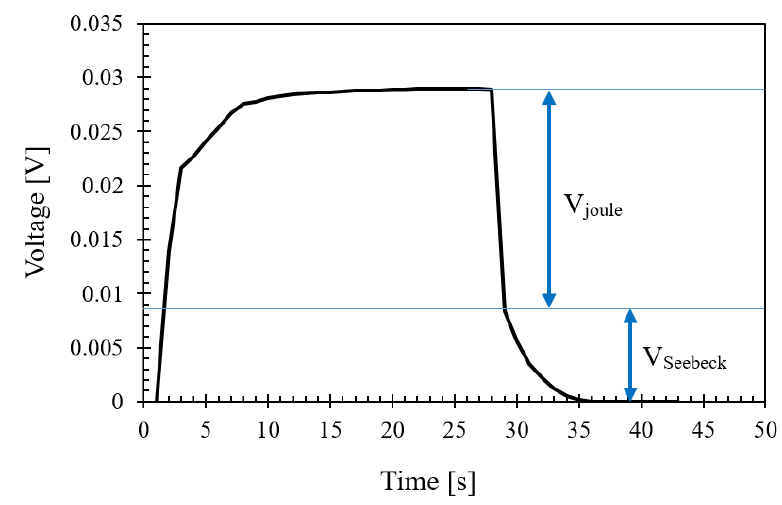
Figure 7. The voltage profile of the TEG obtained via the Harman Figure 7 . The voltage profile of the TEG obtained via the Harman method.